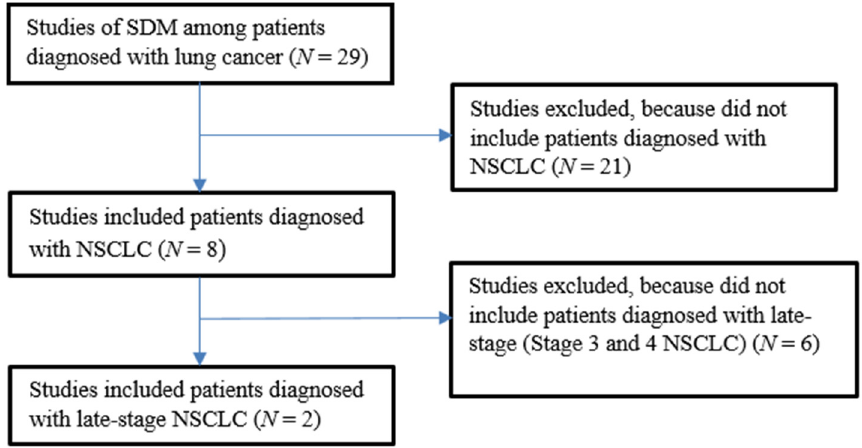
Figure 1. Studies of SDIs and SDM among Patients with non-small cell lung cancer (NSCLC).